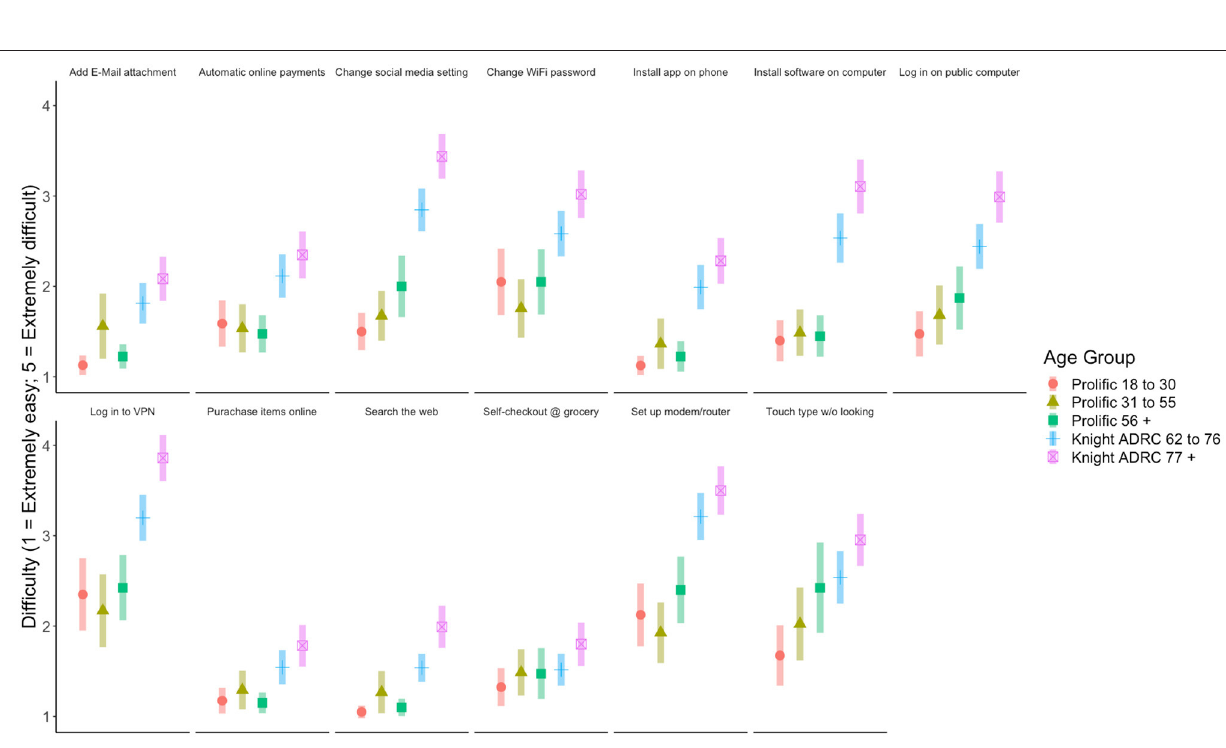
Frontiers in Digital Health |